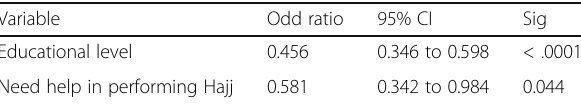
Table 4 Significant odd ratios and 95% CI from multivariate logistic regression analysis predicting positive MINI-Cog Variable